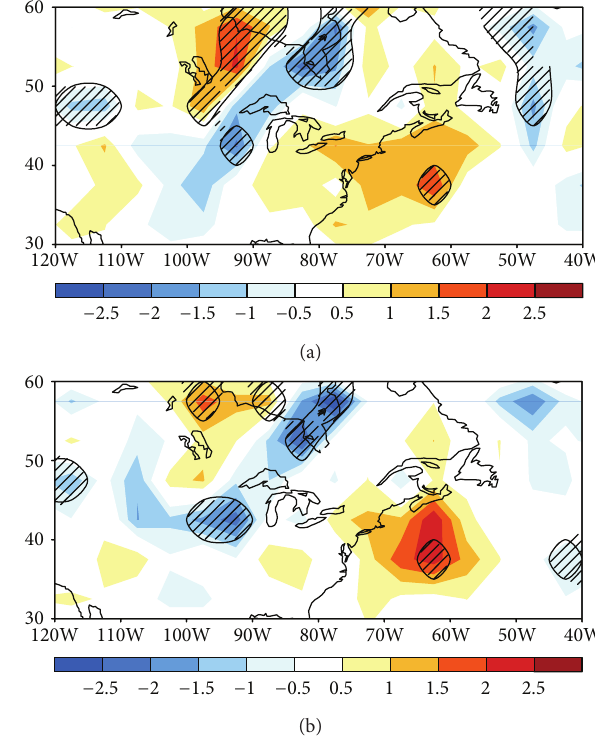
Figure 4: OND cyclone track frequency composite for (a) IOD positive relative to negative for NCEP1 5801 (shaded). 2-tailed 90% significance (hatched), (b) like (a) but for ERA40 5801 Units: number of storms per winter for a 5 ∘ × 5 ∘